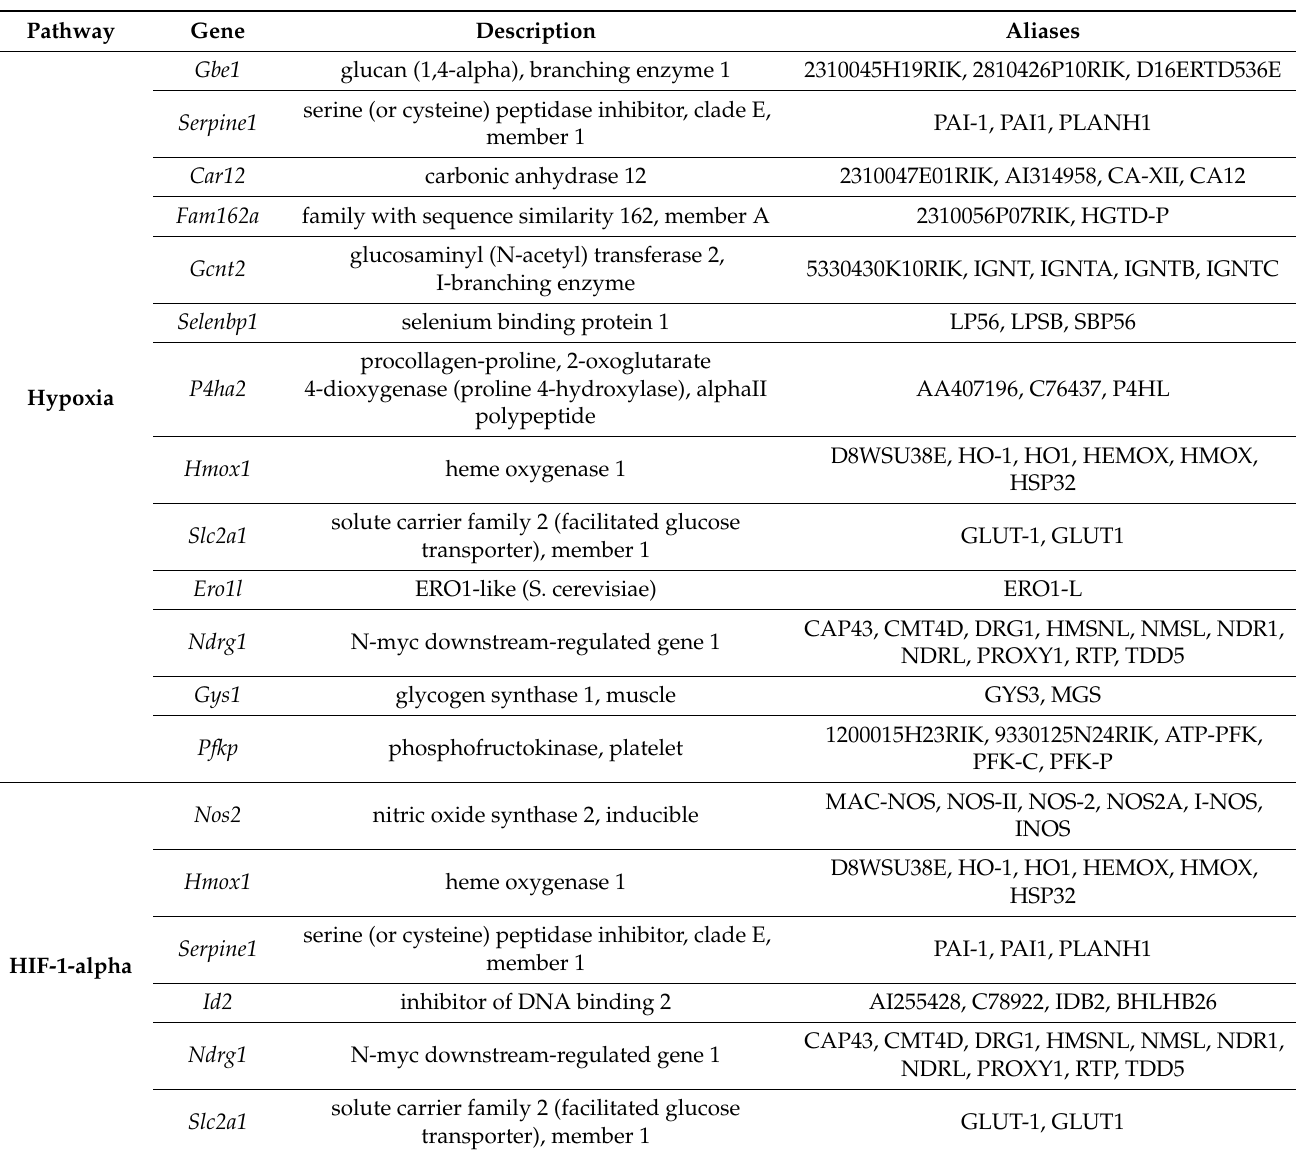
Table 3. List of significant genes associated with Hypoxia and HFI-1